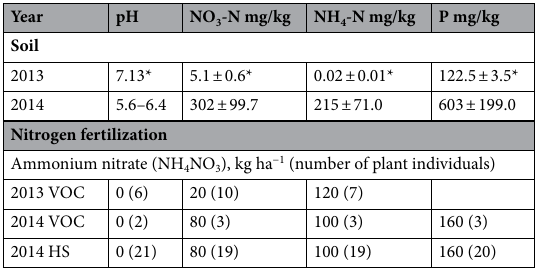
Table 1. Soil pH and nutrient concentrations (before fertilization) and N fertilization rates. The number of plant replicates measured at each N fertilization treatment is in brackets. Field soil in 2013 contains autumn and spring soil content measurements by lactate extractable method for phosphorus with standard errors. Commercial peat soil in 2014 represents nutrient content from manufactory (as standard deviation was taken dry mass by capacity range). *values before mixing with